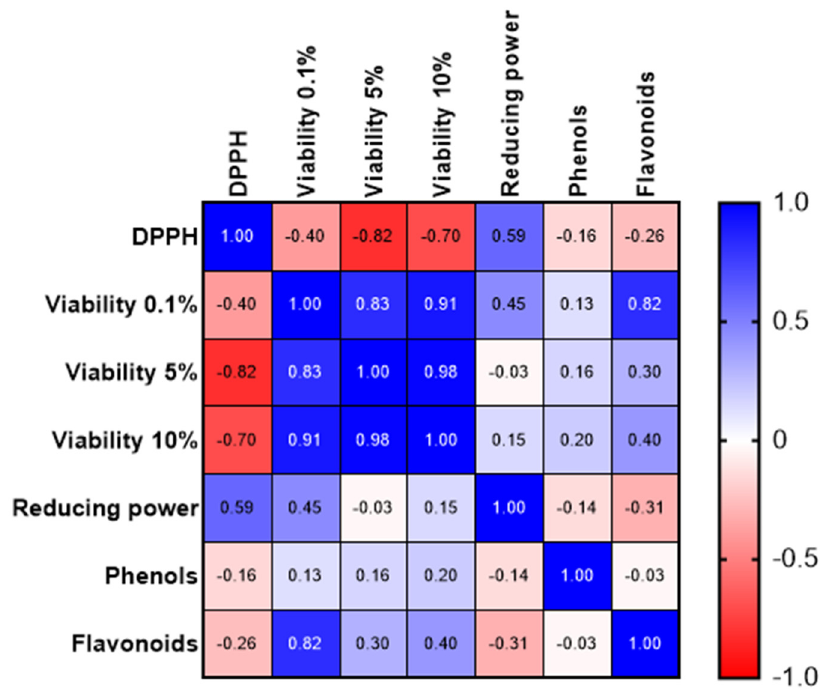
Figure 4. The Pearson-s correlation coefficient between bioactive compounds, antioxidant activity and cell viability.